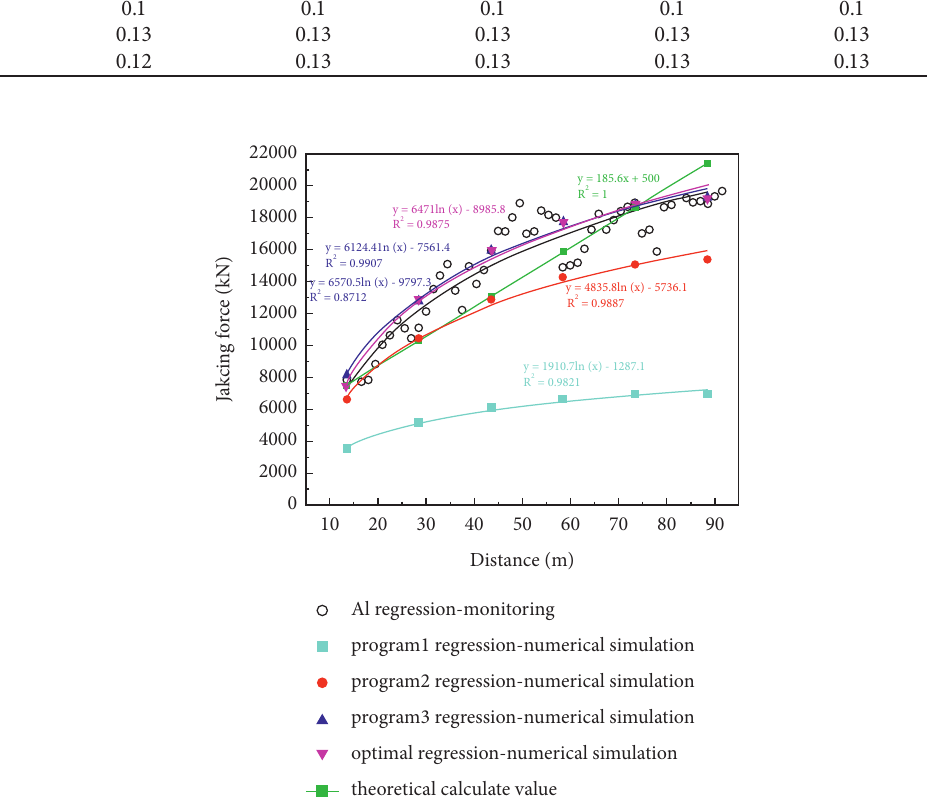
Figure 9: The comparison of jacking forces from monitoring, the empirical equations, and the displacement control method for case A1 (program 1, program 2, program 3, and program 4 (optimal)). Table 8: Comparison of jacking force estimation deviation for case A1 under different grouting pressure programs. Jacking distance